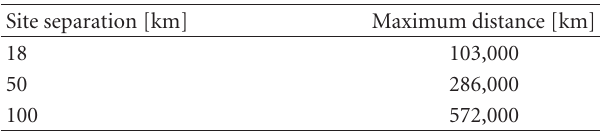
Table 1: Maximal distance from the Earth allowing for the rejection of artificial satellites with the parallax, for the angular size of a pixel of